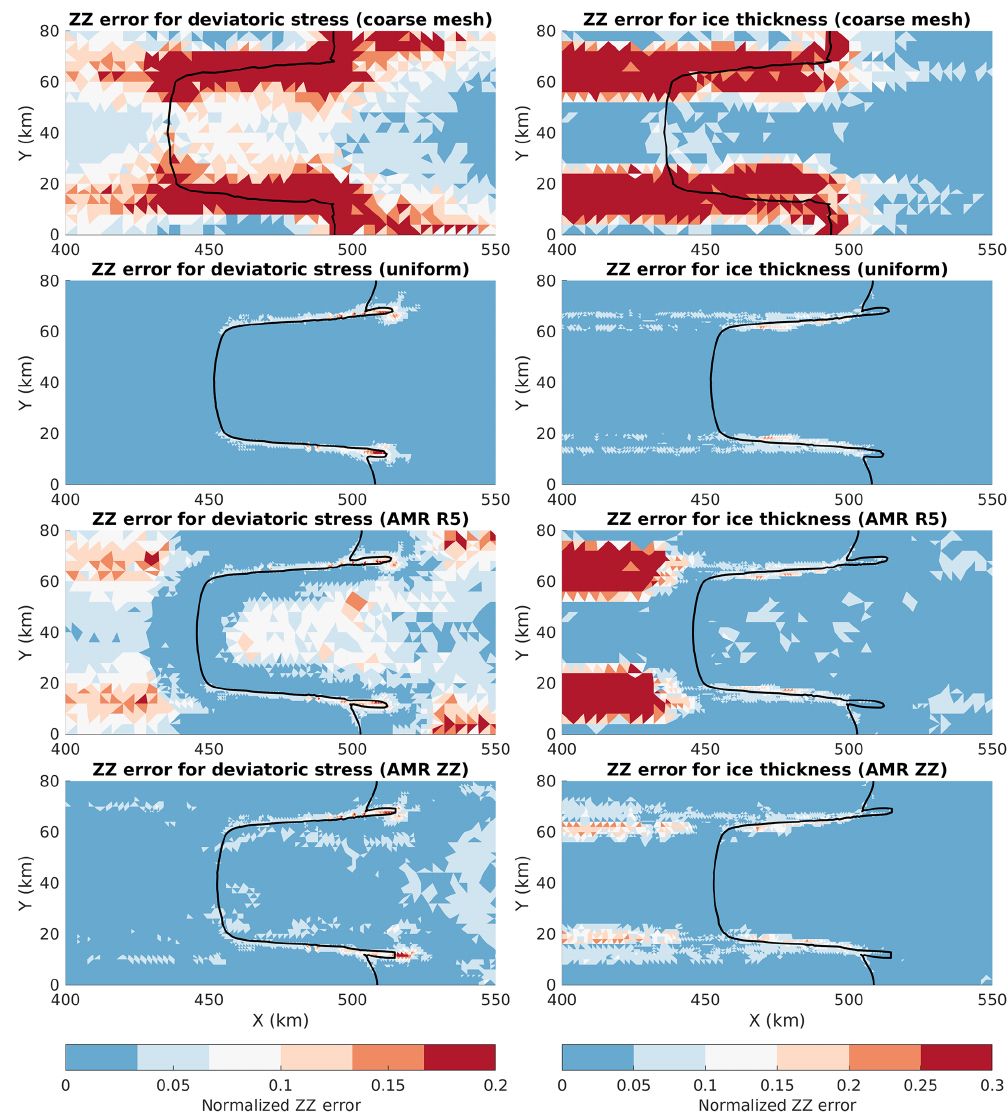
Figure 8. Spatial distribution of the ZZ error estimator in the coarse and refined meshes (uniform and AMR) used in the MISMIP + exper- iments. The ZZ error values are normalized between 0 and 1 using the maximum error value observed in the coarse mesh. Black lines are the grounding line positions at steady state obtained with the respective meshes. The refined meshes (uniform and AMR) are generated by NeoPZ considering the level of refinement equal to 2 (L2; see Table 2), and the criteria used (R5 and ZZ) are summarized in Table 1. The thresholds used in the AMR ZZ are described in the legend of Fig.